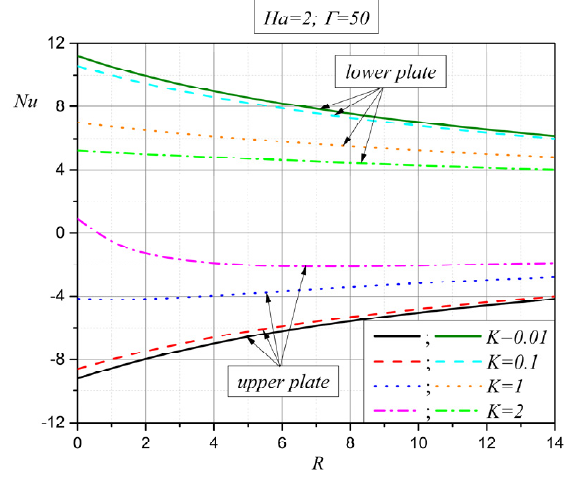
Figure 17. Nusselt number on upper and lower plate for different values of porosity parameter 𝑅 and coupling parameter 𝐾 .